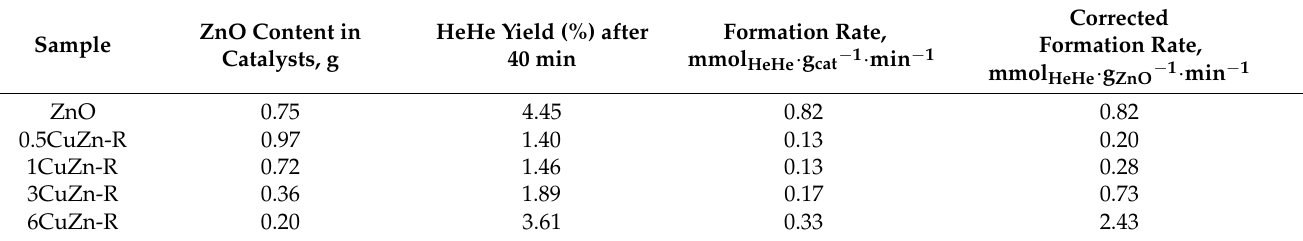
Table 5. The initial rate of HeHe formation calculated for initial 40 min of a reaction between MeHe and 1-Heol on xCuZn-R catalysts. The content of ZnO in the catalysts was taken from Table 1.